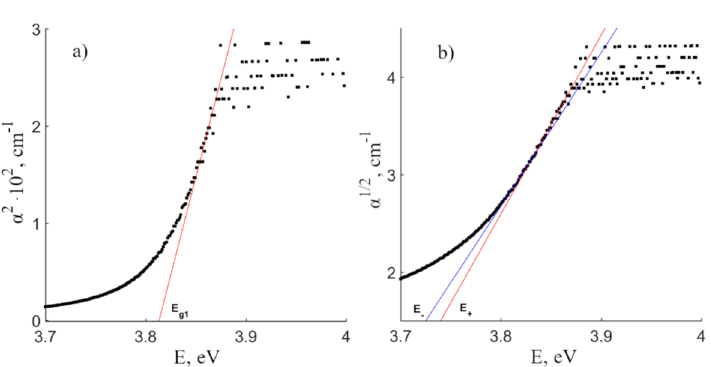
Figure 2. Dependencies α 2 (h ν ) and α 1/2 (h ν ) for determining direct ( a ) and indirect ( b ) transitions in CLN